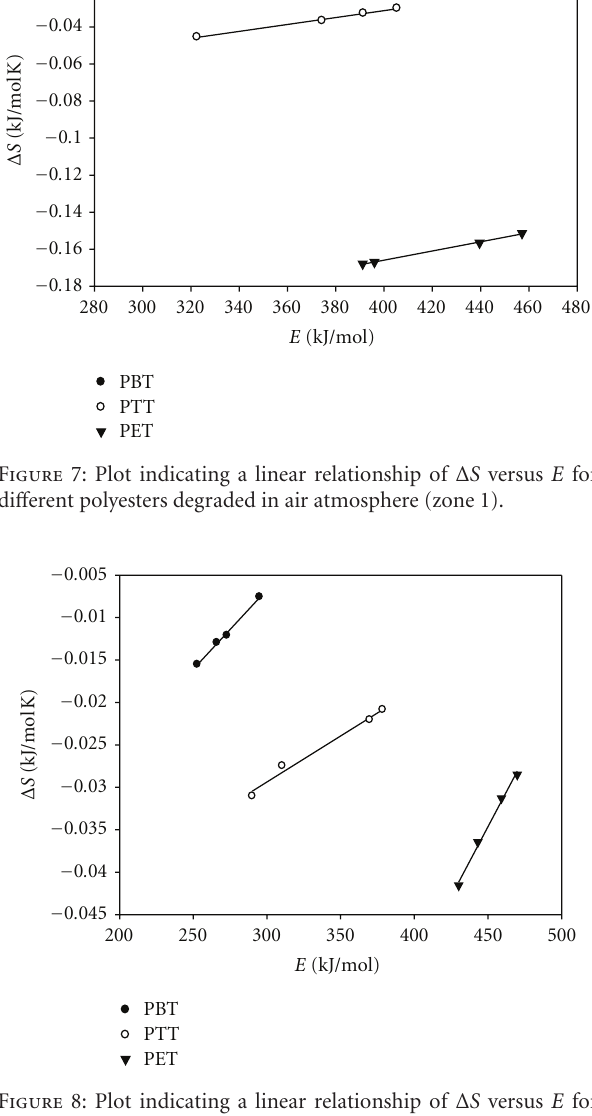
Figure 6: Plot indicating a linear relationship between ln A versus E for di ff erent polyesters degraded in N 2 atmosphere (zone 2).